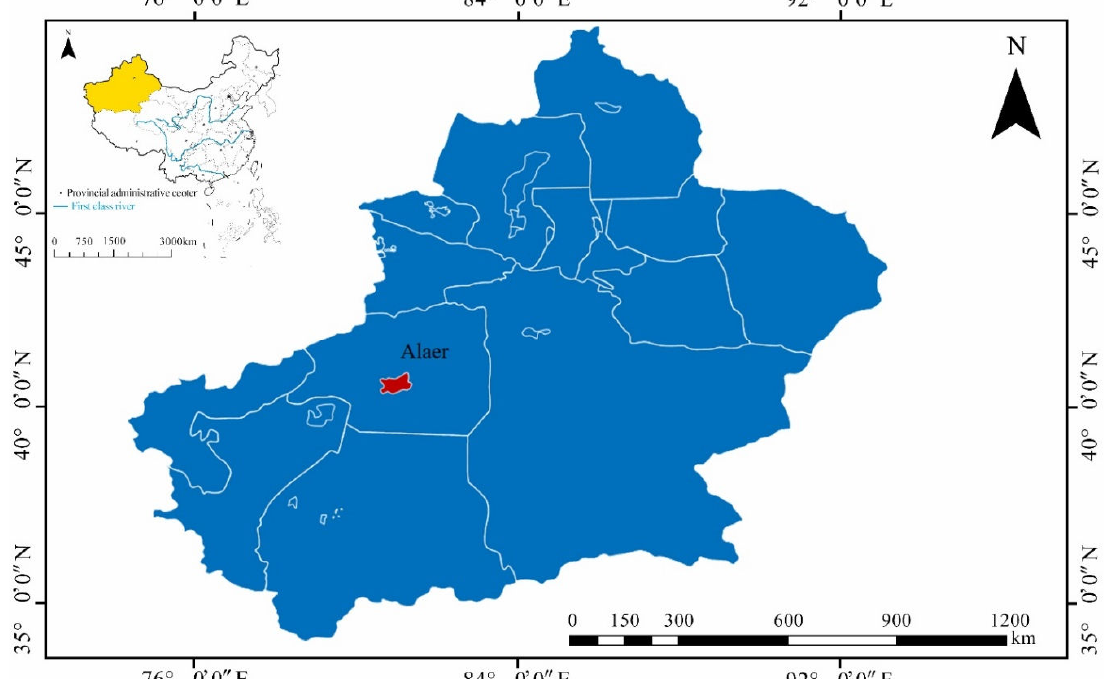
Table 1. Single-fertilization group.